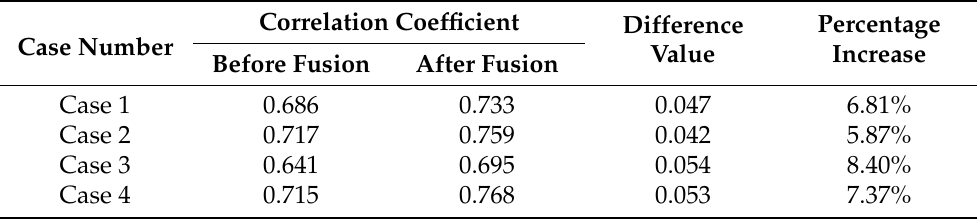
Figure 9. Relation diagram of lateral wind speed and displacement in the mid-span of the bridge after fusion from Cases 1–4. ( a ) Case 1. ( b ) Case 2. ( c ) Case 3. ( d ) Case 4. Table 4. Correlation coefficient of lateral displacement and wind speed in the bridge mid-span before and after